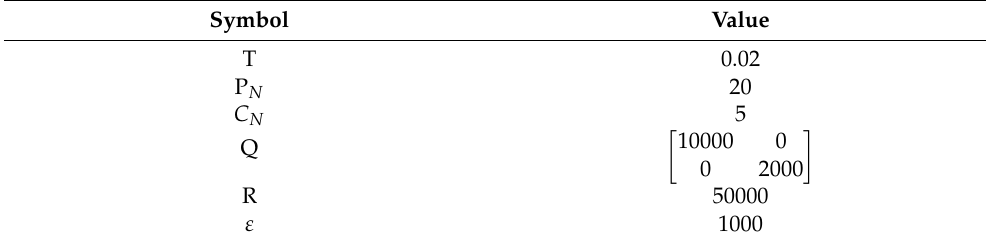
Table 3. Parameters of the MPC controller.